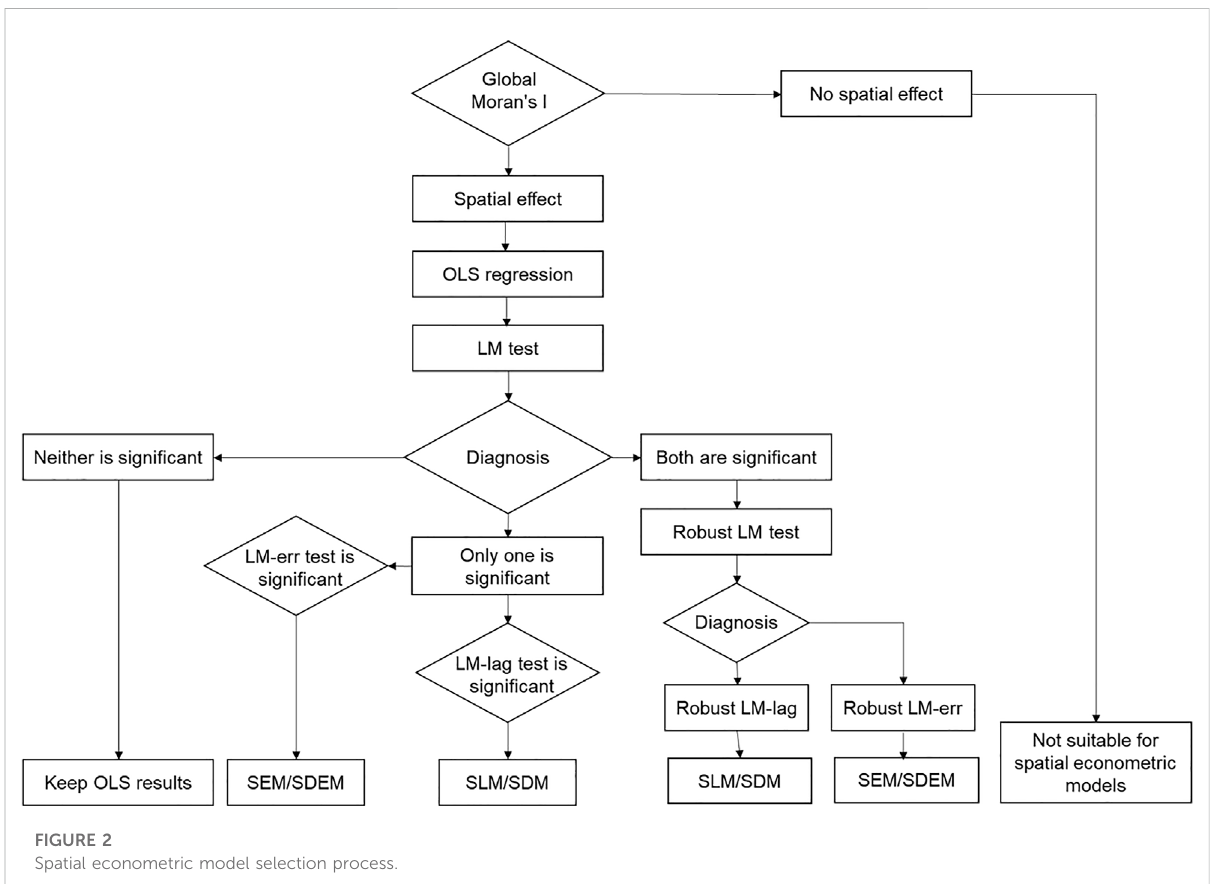
FIGURE 2 Spatial econometric model selection